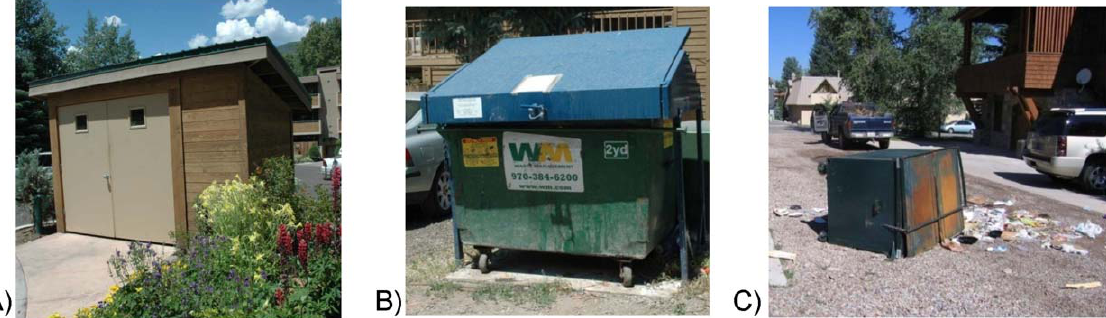
Figure 2. Examples of refuse collector designs. Designs that are considered bear-proof in the city of Aspen and the surrounding residential area of Pitkin County including: A) A low-risk dumpster room with metal doors, round handle, and little door clearance, B) a medium-risk dumpster with bolted, metal lid over a free-standing dumpster, and C) a high-risk free-standing dumpster with top-bar securing method that was toppled and broken into by a